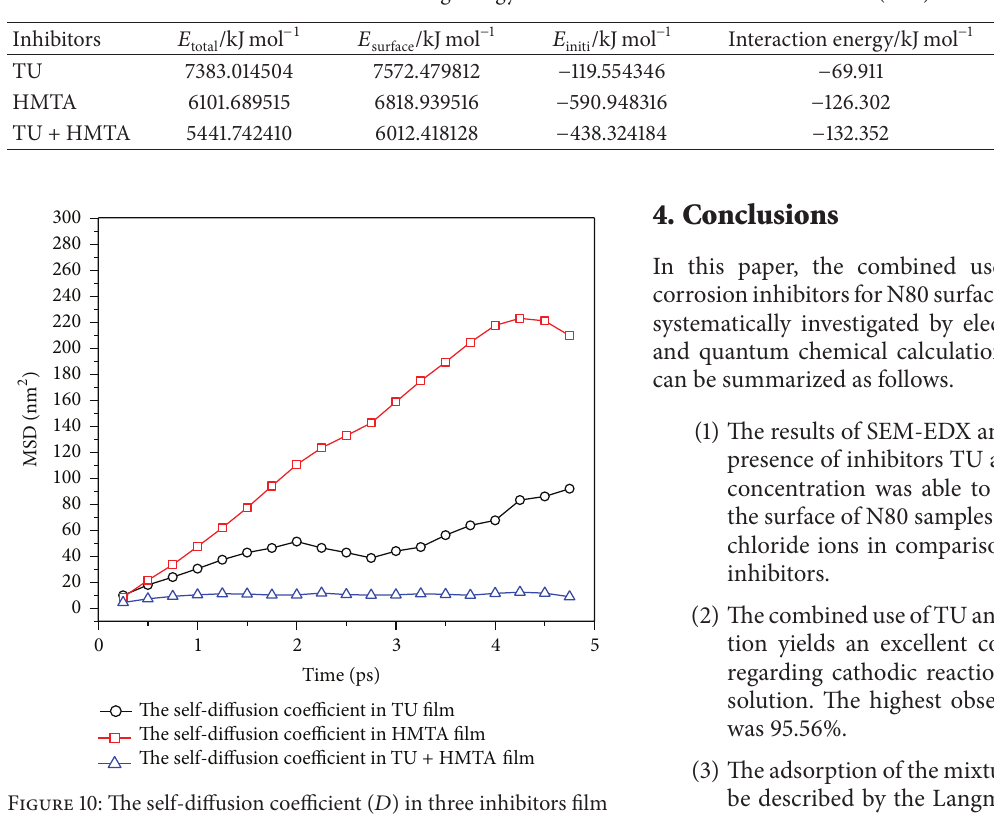
Figure 10: The self-diffusion coefficient ( 𝐷 ) in three inhibitors film at 25 ± 1 ∘